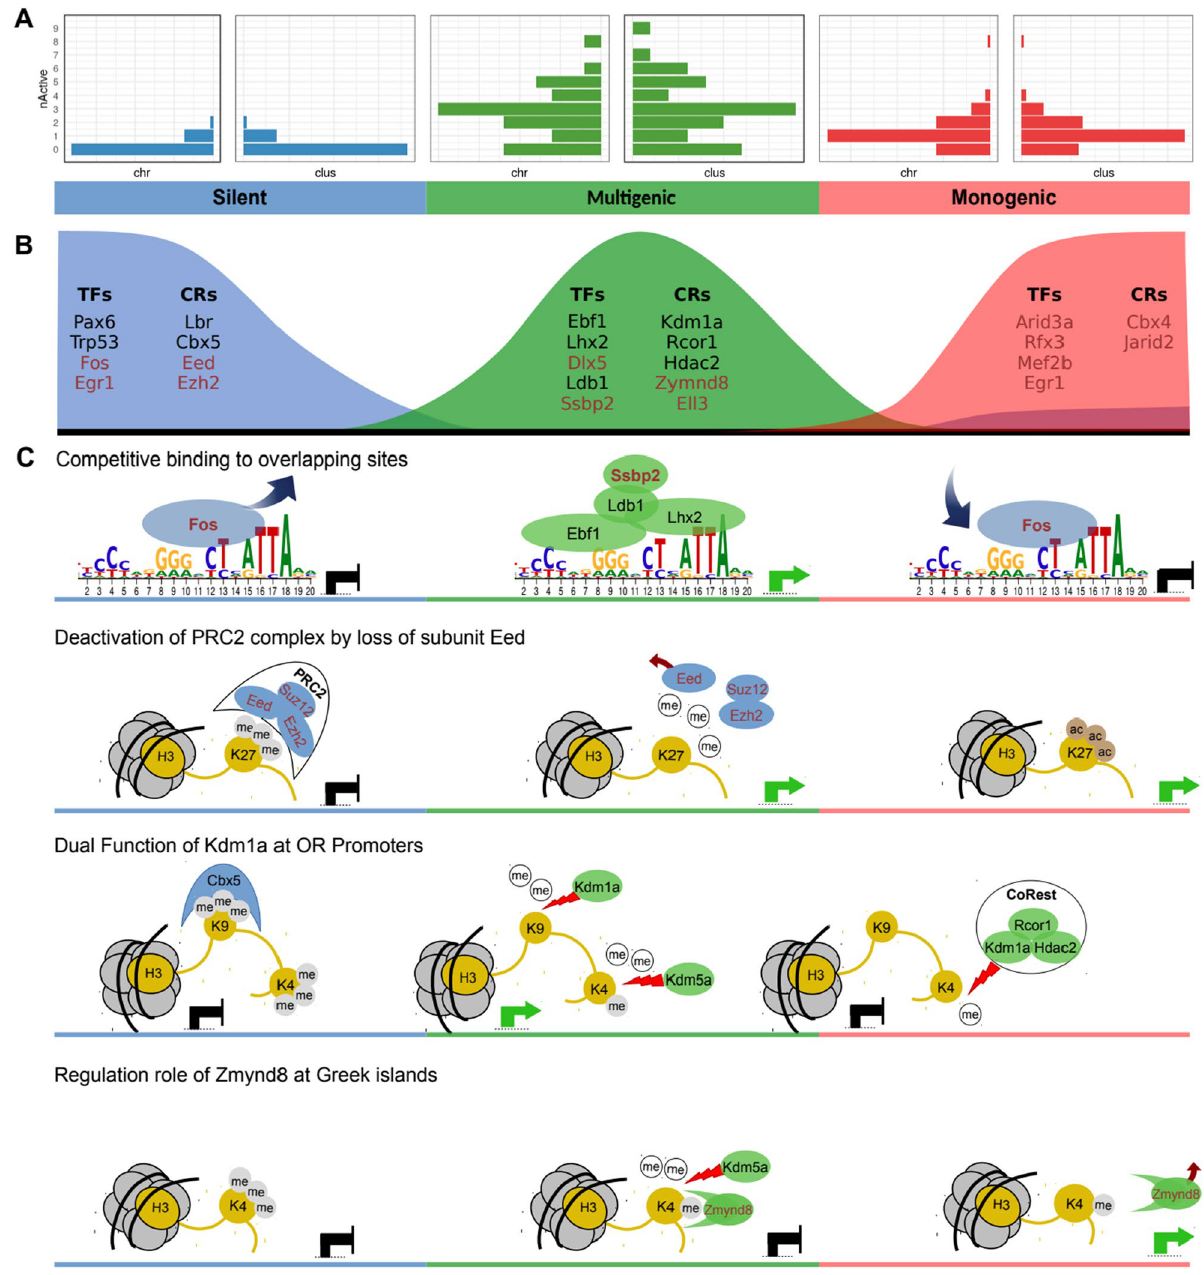
Figure 5. Graphical summary of OR gene expression and hypothetical selection mechanisms. ( A ) Frequency distribution of active OR clusters and chromosomes per cell in the three phases of OR expression (Silent: most cells have 0 active cluster/chromosome, multigenic: 3 active cluster/chromosome is the most frequent case, and in the monogenic phase: most cells have only 1 active cluster/ chromosome). ( B ) Pseudotime ordering of (co-)TFs and remodelers according to peak of expression in one of the three phases. Factors that so far have not been reported are highlighted in red. ( C ) Four mechanisms potentially contributing to OR selection. Factors are colored according to their phase of peak expression. The placement of the nucleosomes is according to the pseudotime at which the respective processes take place. Green arrows indicate an activating effect on target genes, black blunt end arrows indicate an inhibitory effect. Top row: Competitive binding of Fos vs. Ebf1 and Lhx2 to different parts of the Greek island consensus motif, resulting in different enhancer activities during the three OR selection phases. Fos blocks the binding of Ebf1 and Lhx2 to Greek islands in silent phase; in multigenic phase, Fos is significantly downregulated and allows the binding of the super-enhancer-forming complex (Ebf1, Lhx2, Ldb1, Ssbp2). Finally, when the OR selection is made during the monogenic phase, Fos is expressed again. Second row: Downregulation of the Eed subunit dissolves the PRC2 complex at the beginning of the multigenic phase and thus enables access